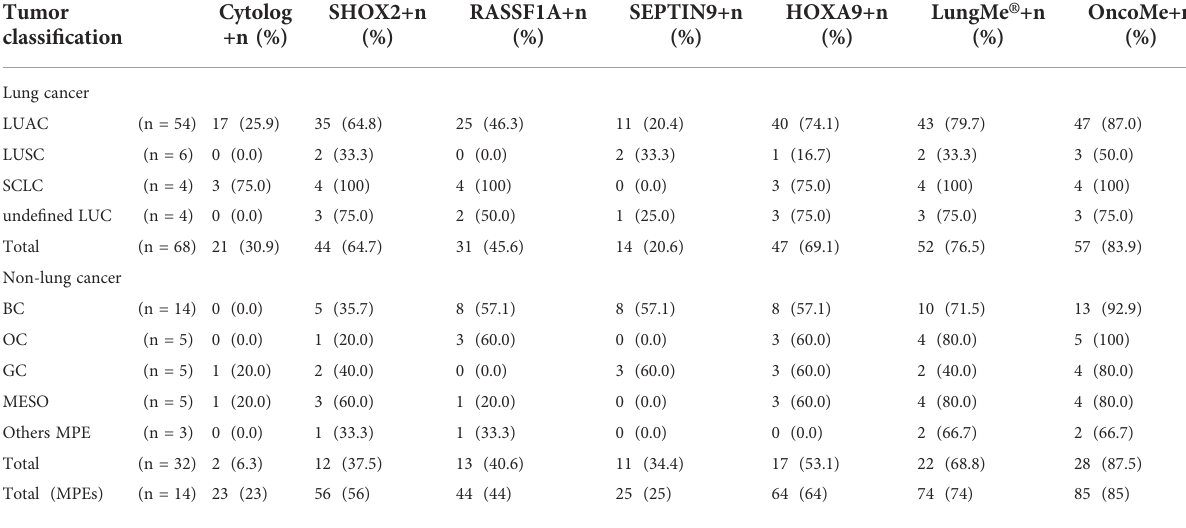
TABLE 2 Diagnostic yield of cytology and methylation analyses in different subgroups of MPEs. Tumor classi fi